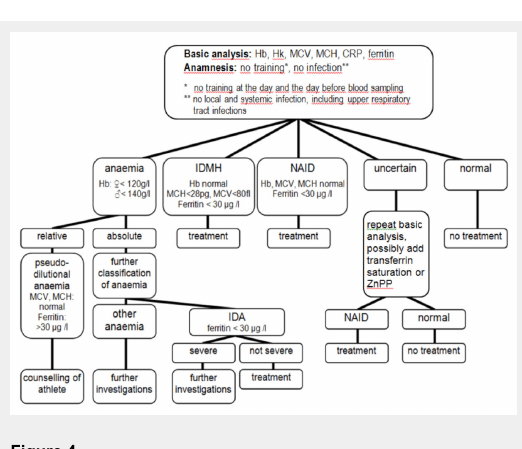
Figure 4 Overview of diagnosis and indications for treatment in adults. CRP = C-reactive protein; Hb = haemoglobin; Hk = haematocrit;IDA = iron deficiency with anaemia; IDMH =iron deficiency with microcytosis and/or hypochromia; MCH = mean cellular haemoglobin; MCV = mean cellular volume; NAID = nonanaemic iron deficiency; ; ZnPP = zinc